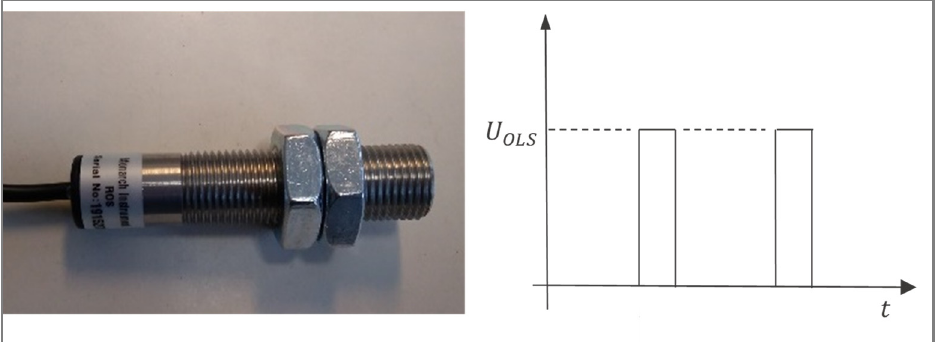
Figure 4. The optical LED sensor and its output voltage signals.